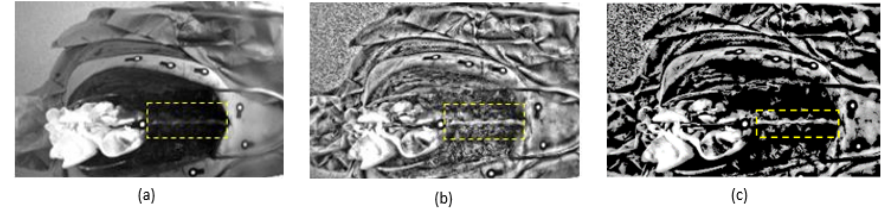
Figure 5. Image preprocessing to improve feature detection. ( a ) Original image view, ( b ) result after preprocessing, ( c ) spine segmentation after image thresholding indicated by the dotted